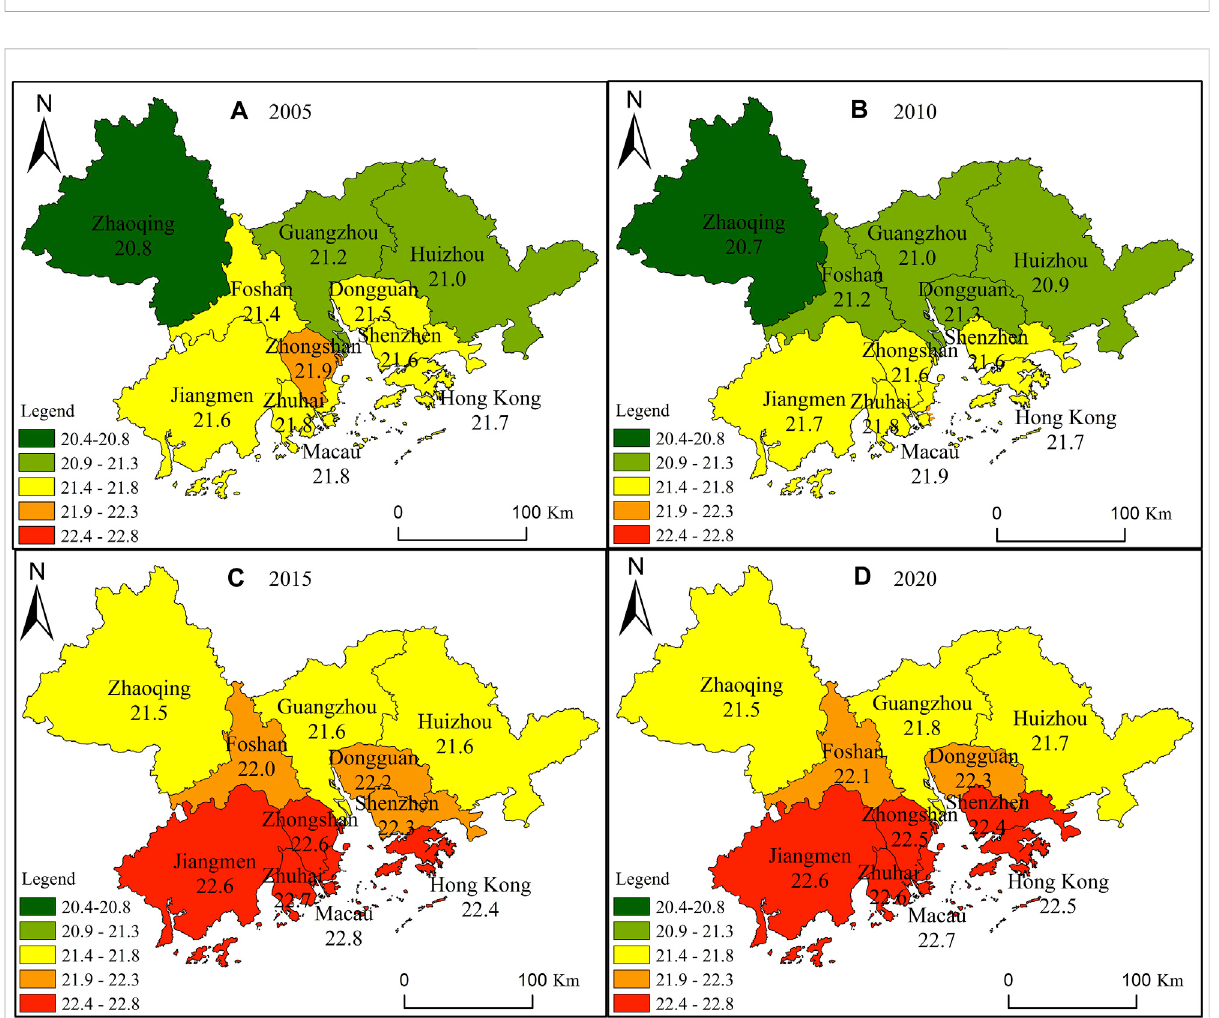
FIGURE 3 Theannualchangeoftemperature-humidityindexintheGuangdong – HongKong – MacauGreaterBayAreain (A) 2005, (B) 2010, (C) 2015,and (D)